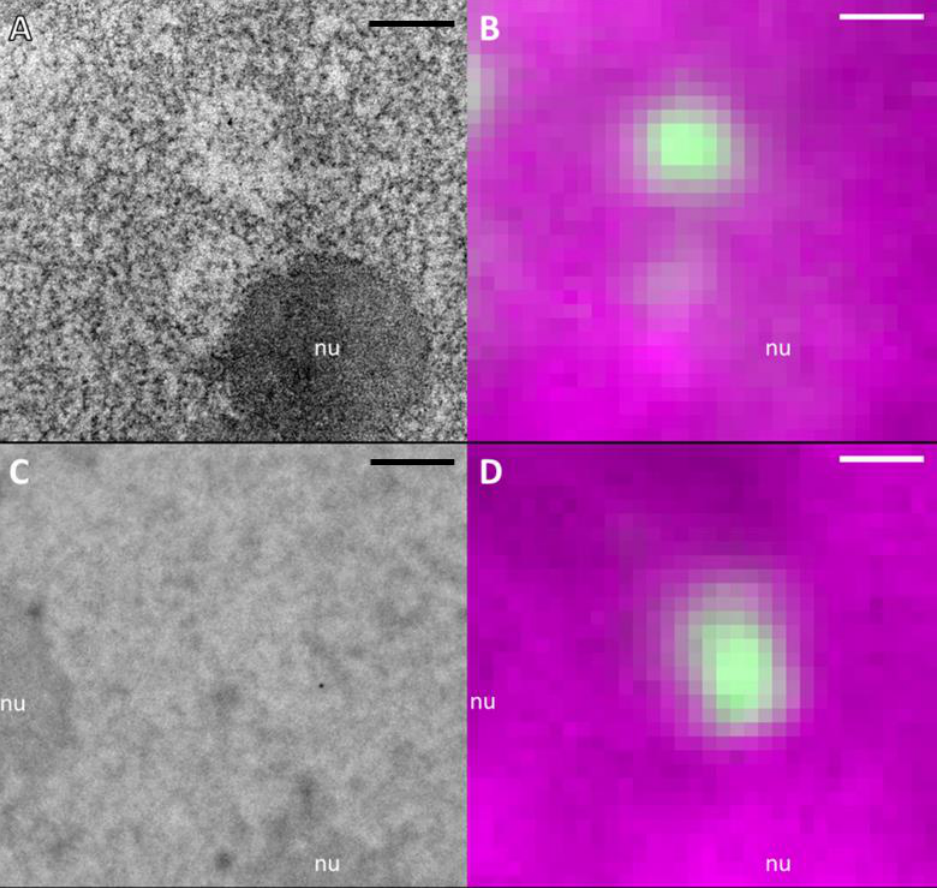
Figure 7. LDA phenotype at damage sites of RNA-specific stained (terbium-citrate; Tb) sections vanish after RNase treatment. Sections of U2OS nuclei irradiated with carbon ions, fixed 1 h after irradiation and stained with Tb ( A ) show LDAs correlating with 53BP1 signal ( B , green). After 24 h treatment with RNase no LDAs are visible ( C ) at the damage site ( D ). All scale bars: 1 µm.